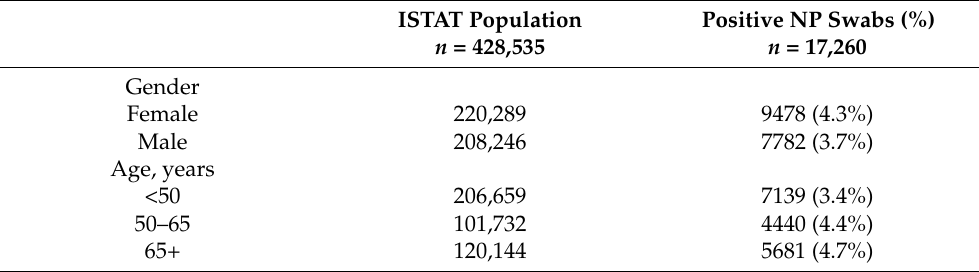
Table 1. Gender and age distribution for the total population and subjects with at least one positive NP swab. Prevalence of positive NP swabs is reported in